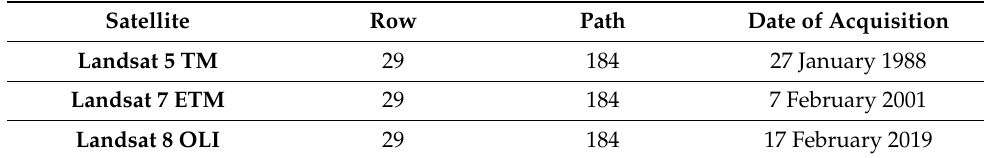
Table 2. Landsat scenes used in the analysis. Satellite Row